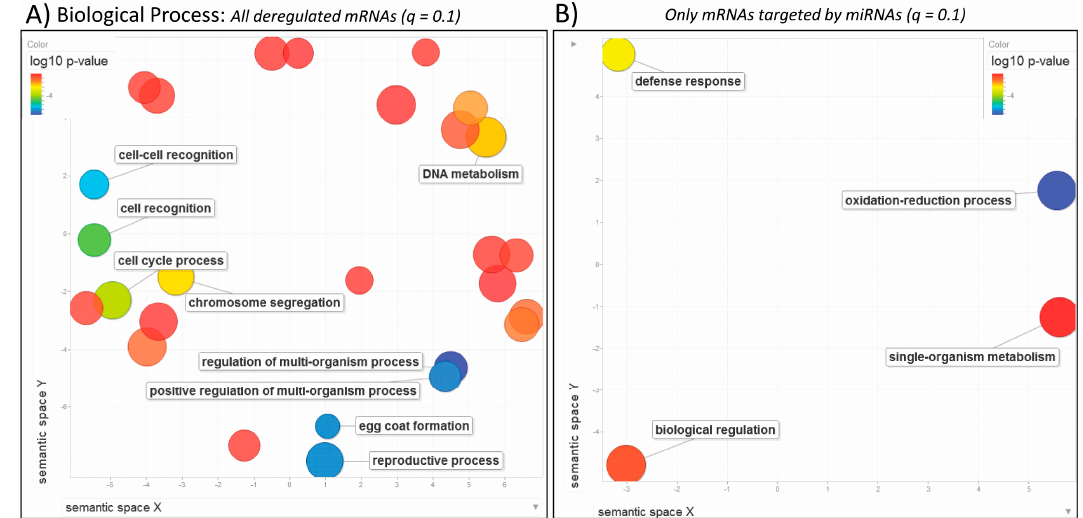
Figure 3. Biological Process. REduce & VIsualize Gene Ontology (REViGO) plots showing categories in 2D space for ( A ) all deregulated mRNAs obtained from DESeq2 (q ≤ 0.1) and ( B ) mRNAs that are predicted targets of the miRNAs identified by miRNA ‐ Seq (q ≤ 0.1). Blue and green bubbles represent Gene Ontology (GO) terms with more significant p ‐ values than the orange and red bubbles. Only the most significant terms are labeled, i.e., regulation of multi ‐ organism and reproductive processes, and oxidation ‐ reduction process. Closeness on the plot reflects semantic similarities between the GO terms. Bubbles of more general terms are larger. Only the most significant terms are labelled when space is an issue.